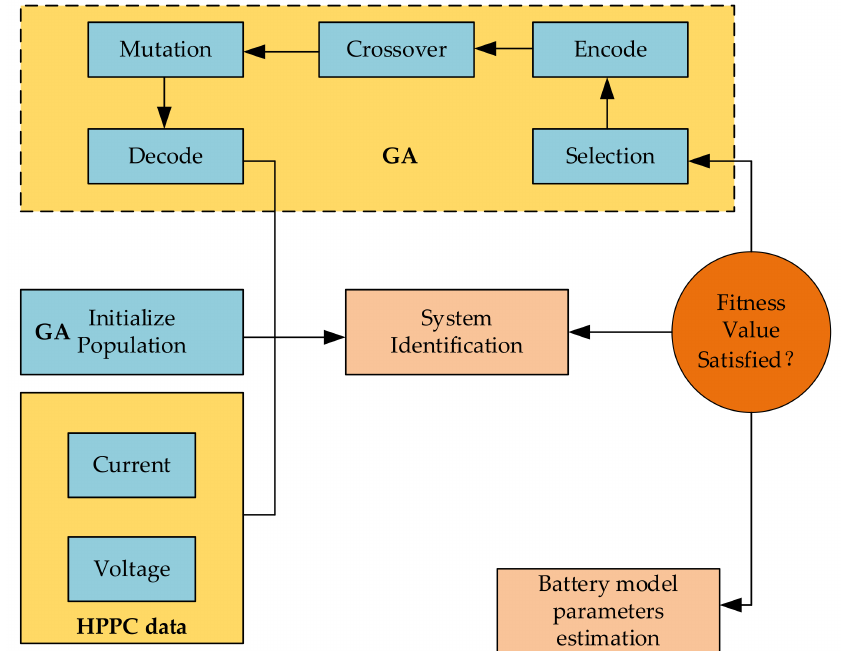
Figure 6. Battery model parameters determination using